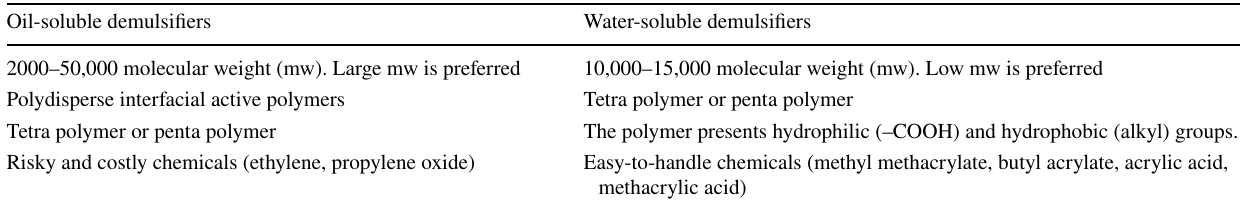
Table 4 Comparison between oil-soluble and water-soluble demulsifiers (Matijasevic and Banhart 2006) Oil-soluble demulsifiers Water-soluble demulsifiers Polydisperse interfacial active polymers Tetra polymer or penta polymer Tetra polymer or penta polymer The polymer presents hydrophilic (–COOH) and hydrophobic (alkyl) groups.